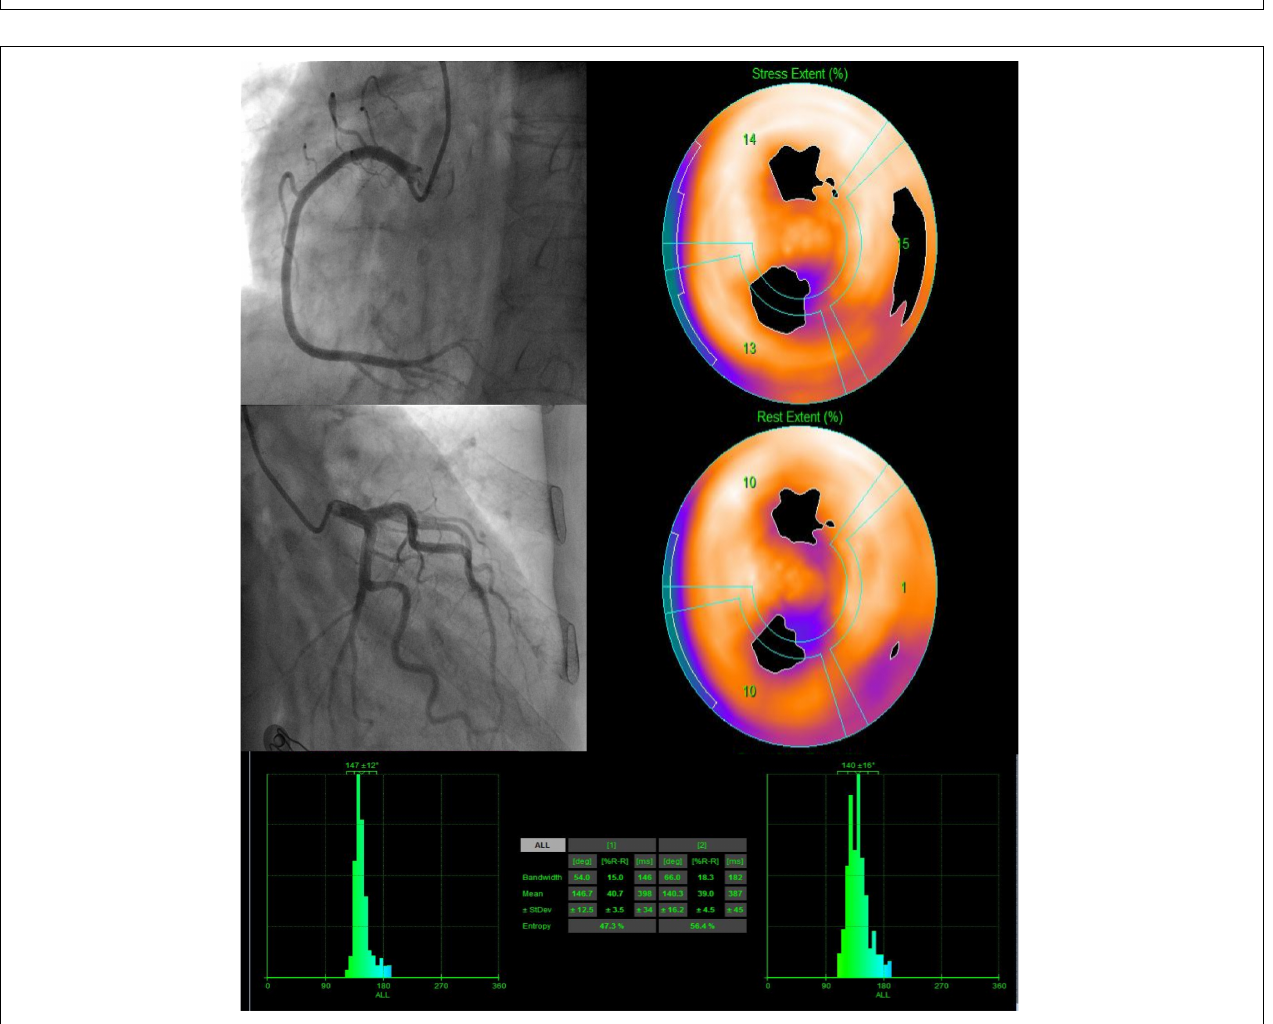
FIGURE 4 | A 82-year-old female patient with INOCA (LAD stenosis 30%, SSS = 8, SDS = 4) presented LVMD under both stress and rest. After 20 months of follow-up, she was hospitalized for heart failure.